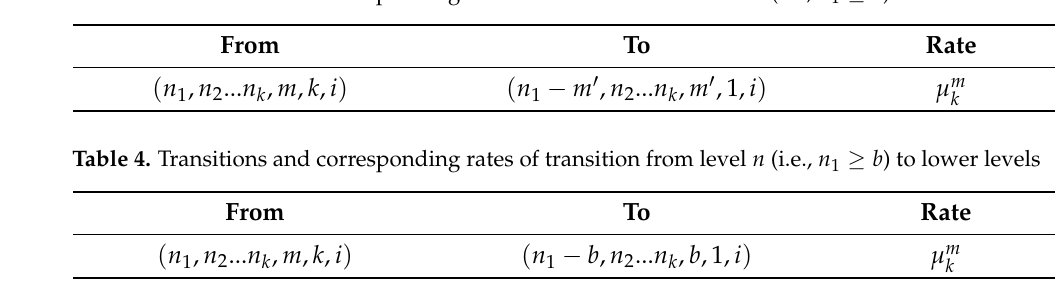
Table 5. Transitions and corresponding rates of transition from level n ≥ 1 (i.e., n 1 ≥ a ) to level n + 1. From To